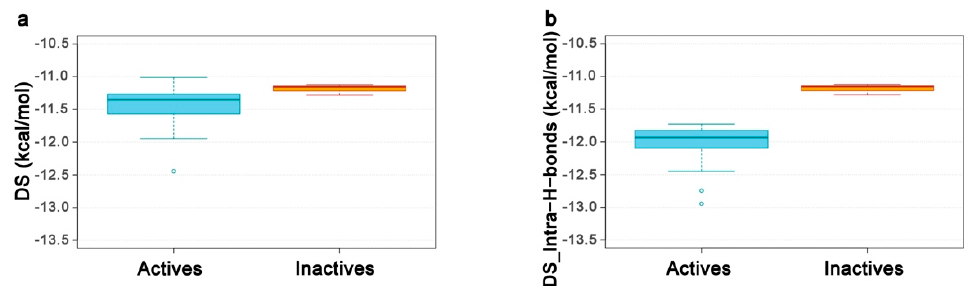
Figure 6. Box-plots showing docking scores distribution obtained for active and inactive compounds using glide standard precision ( a ) without intramolecular hydrogen bonds contribution and ( b ) rewarding intramolecular hydrogen bonds.